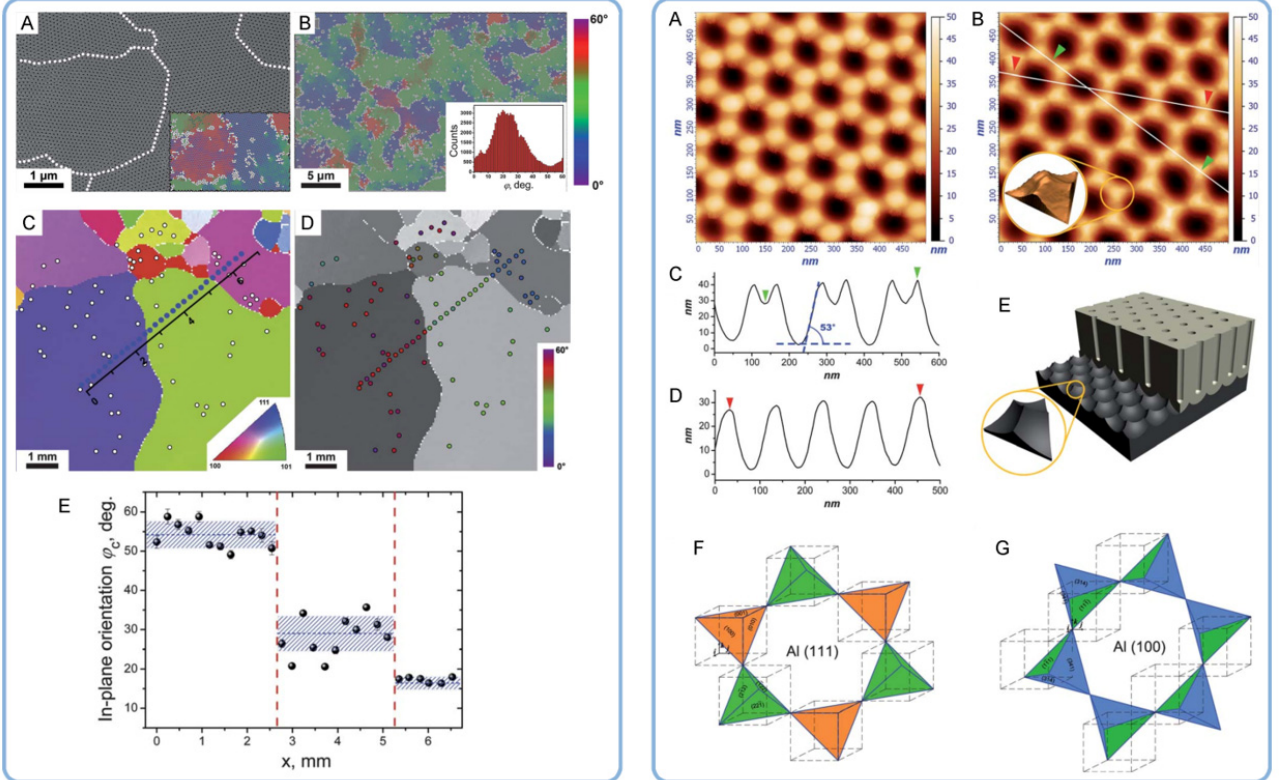
Figure 10. Left side : ( A ) An HRSEM image of PAA showing the boundaries between highly ordered pore domains (marked with dotted lines); ( B ) A lower magnification image in which pores are color-coded with respect to their average angles to the nearest neighbors; ( C , D ) Electron Backscatter Diffraction (EBSD) orientational distribution maps showing crystallographic orientations of Al grains, the colored points show the spots where SEM analysis of PAA was performed, the inset in ( C ) explains the color-coding of the crystallographic orientation of Al grains, the inset in ( D ) explains the color-coding of the detected average preferential pore orientation in PAA; ( E ) The spread of the preferential orientations of the porous structure measured along the blue dotted line in ( C ). Right side : ( A , B ) AFM images obtained from the bare metal surface after the removal of PAA; ( C , D ) AFM height profiles measured along the white lines in ( B ); ( E ) A schematic of the Al/PAA structure (the inset shows an individual pyramid between three neighboring pores, around which, according to Napolskii et al., the rotation of a PAA lattice is supposed to occur until the optimal orientation with respect to the crystallographic direction in Al is achieved); ( F , G ) Crystallographic orientation of the sides of pyramids for (111) and (100) single crystal Al substrates. Adapted with permission from [101]. Copyright 2012 The Royal Society of Chemistry.